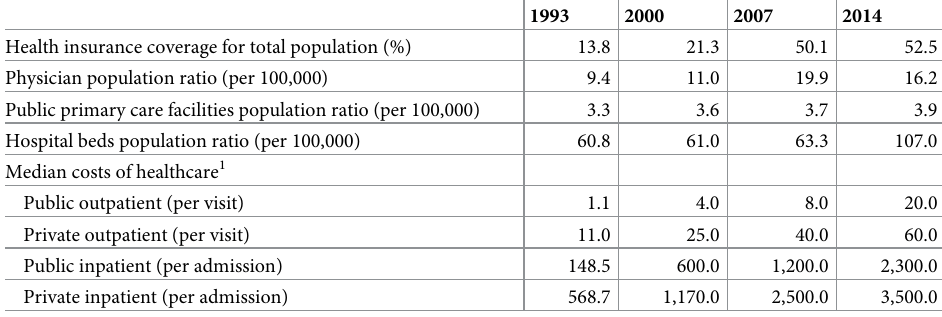
Table 5. Trends of demand and supply-side factors in healthcare utilisation in Indonesia,